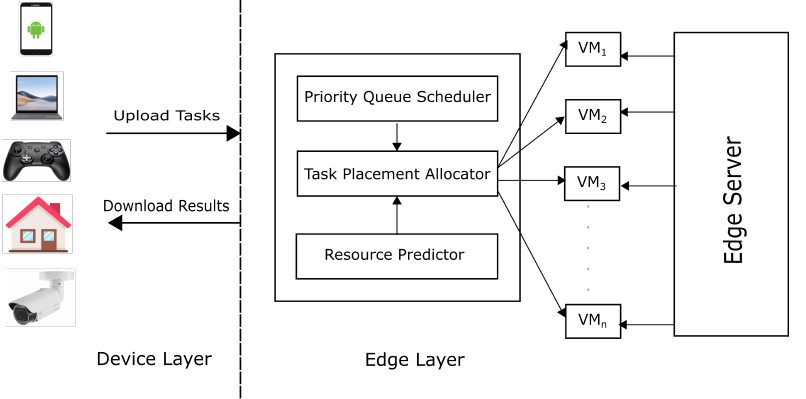
Figure 1. MEC network